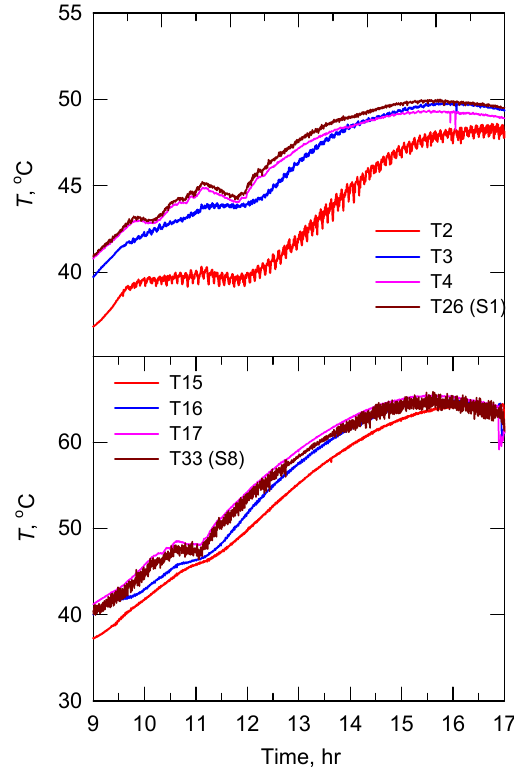
Figure 7. Temperature variation in the tanks 1 and 8, 0.8 LPM case.